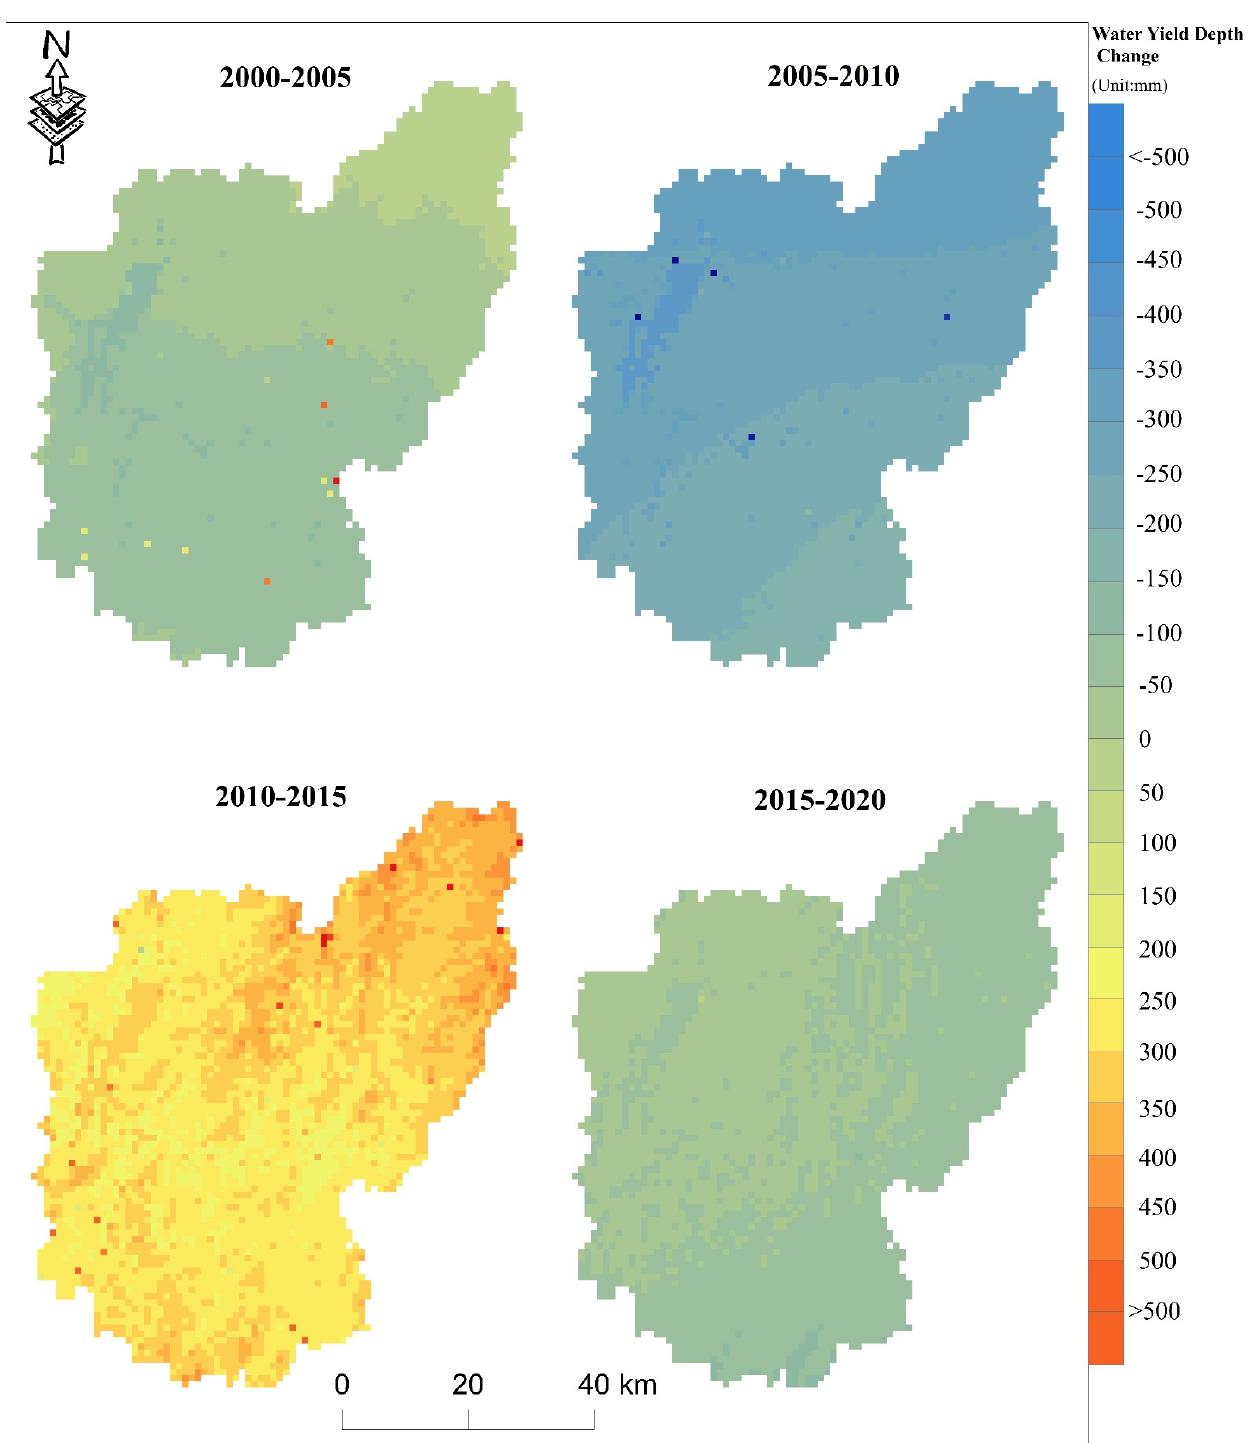
Figure 5. Spatial distribution of water production changes in the Dongjiang Lake Basin.